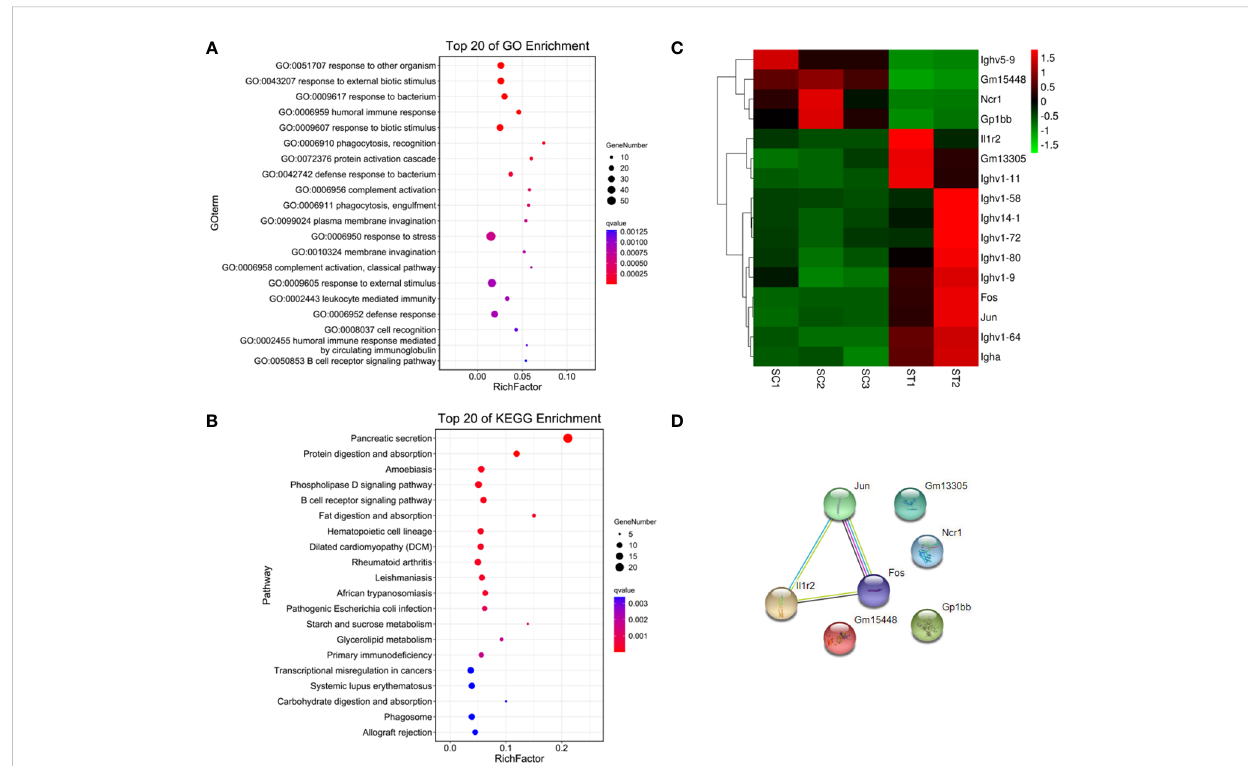
FIGURE 4 Functional enrichment and interaction analysis of DEGs in spleen tissue of ART offspring. (A, B) Gene ontology (GO) and Kyoto Encyclopedia of Genes and Genomes (KEGG) enrichment analysis of DEGs in spleen (top 20), respectively; (C) heatmap shows 16 DEGs included in immune related pathways; (D) the interaction analysis of the above 16 DEGs was performed using STRING